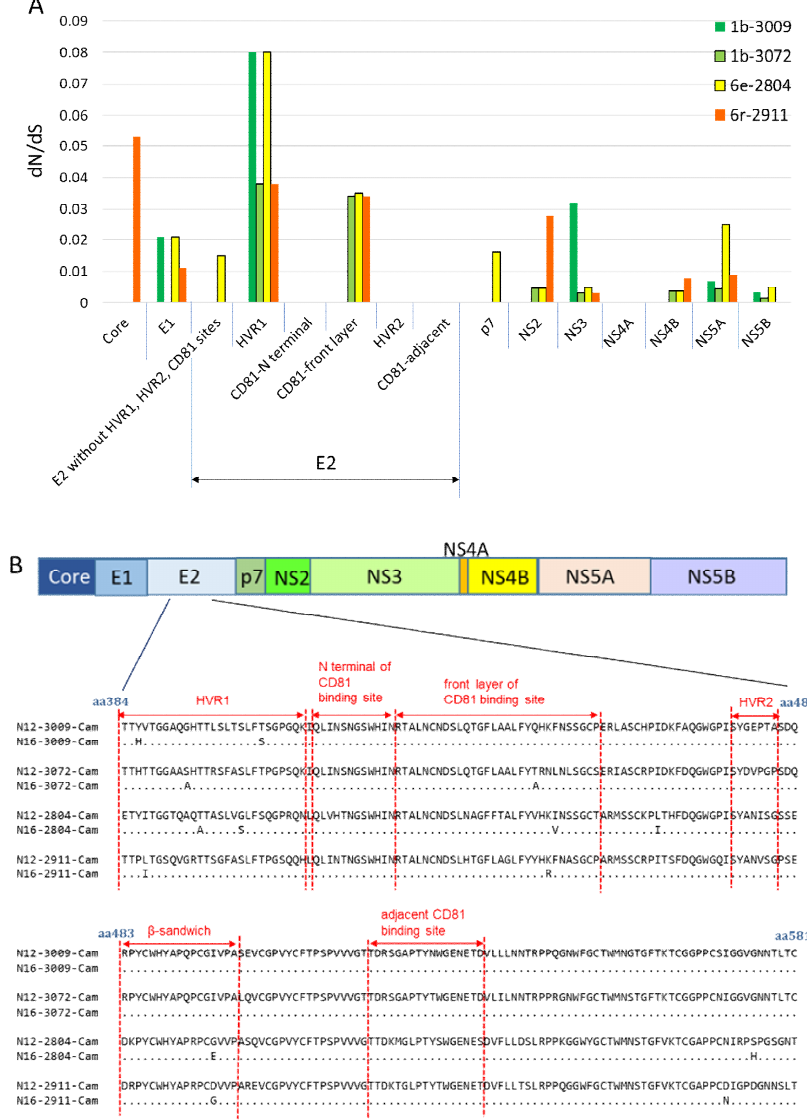
Figure 5. Immune pressure on HCV RNA and amino acid mutation of E2 ( A ) Immune pressure in each area of HCV RNA among four Cambodian subjects Ten areas of HCV RNA and six loci in E2 are described. ( B ) Amino acid mutation of the HVR, CD81 binding site (CD81bs), and β -sandwich in E2 over 4.12 years. The amino acid sequence at E2 at two points among the four subjects is indicated. Red dotted lines indicate HVR1 (aa 384–410), HVR2 (aa 474–480), N-terminus of CD81bs (aa 412–423), the front layer of CD81bs (aa 424–453), the adjacent CD81-binding loop (aa 519–535), and the β -sandwich (amino acids 483–499). Of the three regions of the CD81-binding site, nonsynonymous substitution occurred only at the front layer in 1b (No.3072), 6e (No.2804), and 6r (No.2911), whereas in the remaining two regions (N-terminal and adjacent), no nonsynonymous substitution was observed (Figure